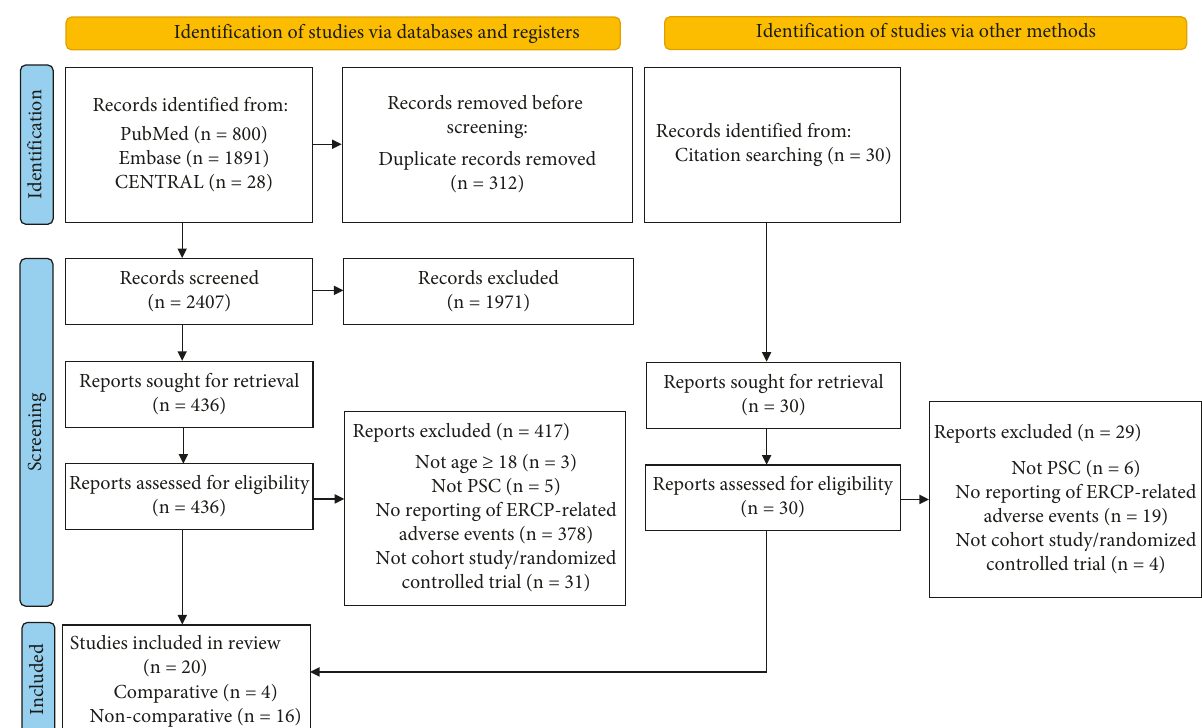
Figure 1: Flow diagram of study selection according to Preferred Reporting Items for Systematic Reviews and Meta-Analyses